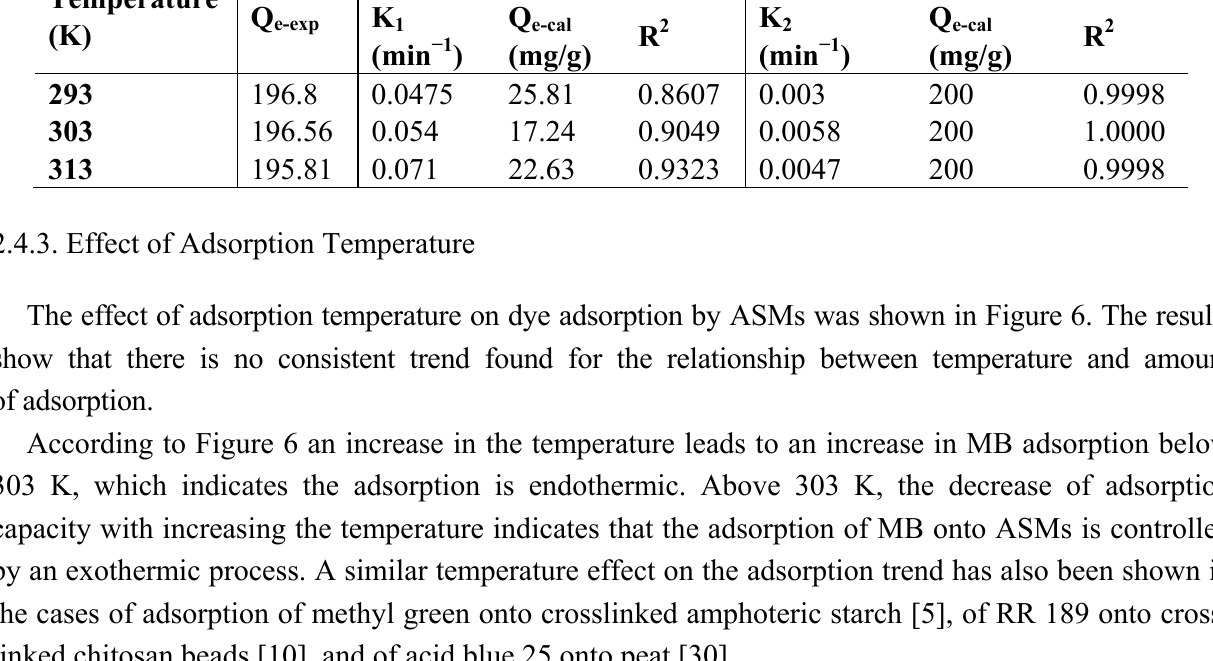
Figure 6. Effect of adsorption temperature on MB adsorption by ASMs.C